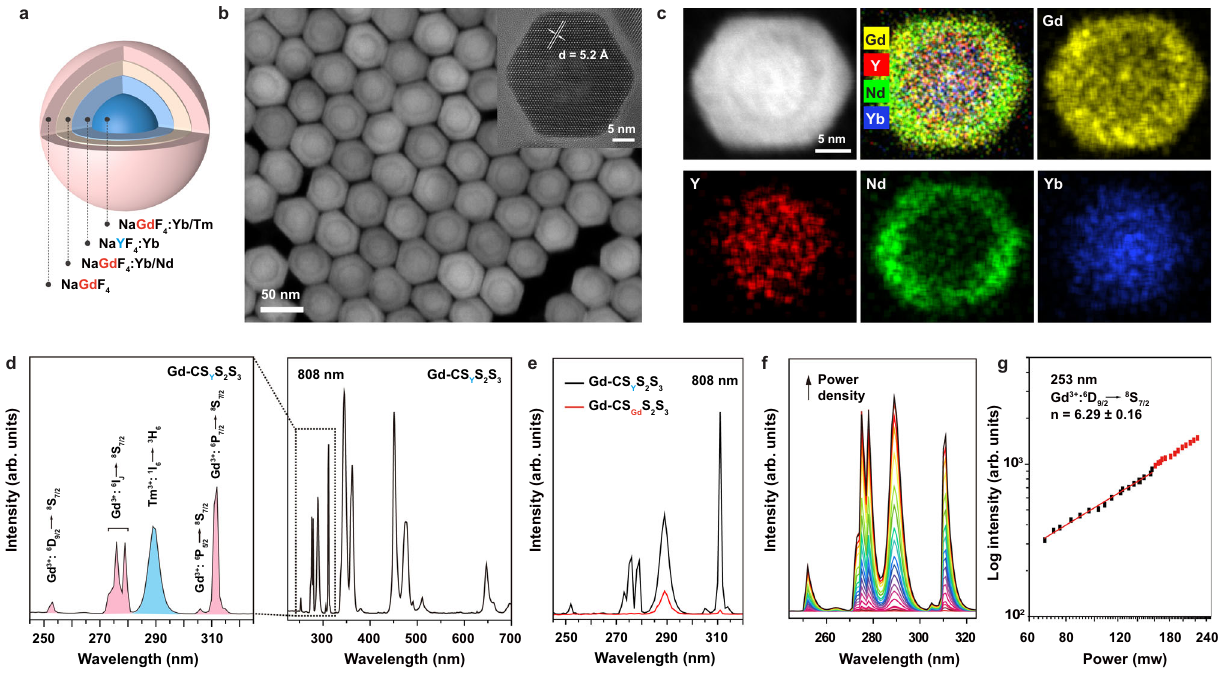
Fig. 3 Structural and optical characterizations of Gd-CS Y S 2 S 3 nanoparticles before and after cation exchange. a Schematic illustration of the as- synthesized Gd-CS Y S 2 S 3 nanoparticles. b High-angle annular dark- fi eld scanning transmission electron microscopy (HAADF-STEM) image and high- resolution TEM image of the corresponding nanoparticles (inset). c HAADF-STEM image and elemental mapping of a single Gd-CS Y S 2 S 3 nanoparticle, indicating the spatial distribution of the Gd, Y, Nd, and Yb elements in the core-multishell structure. d Room-temperature emission spectra of Gd-CS Y S 2 S 3 nanoparticles in cyclohexane under 808 nm excitation. e Emission spectra of Gd-CS Y S 2 S 3 and Gd-CS Gd S 2 S 3 under excitation of 808 nm CW diode laser. The excitation power density is 10 W cm − 2 . f Excitation-power-dependent UV upconversion emission spectra of Gd-C Y S 2 S 3 nanoparticles under 808 nm excitation. g Log intensity-pump power of the 253 nm upconversion emission of Gd-C Y S 2 S 3 nanoparticles under 808 nm